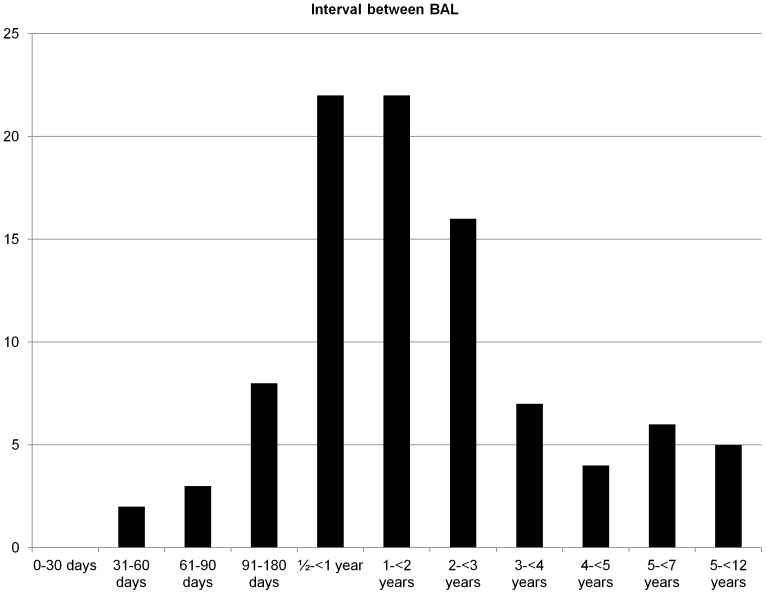
Interval between bronchoalveolar lavages in healthy never-smoking subjects undergoing more than one investigation (number of investigations on y-axis).